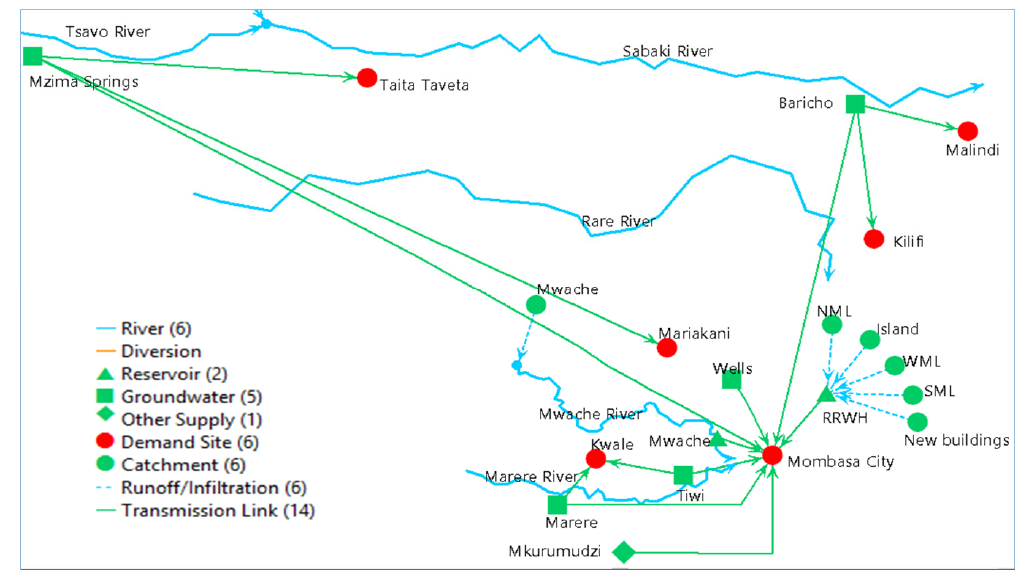
Figure 5. Conceptual model for Mombasa city (not drawn to scale).